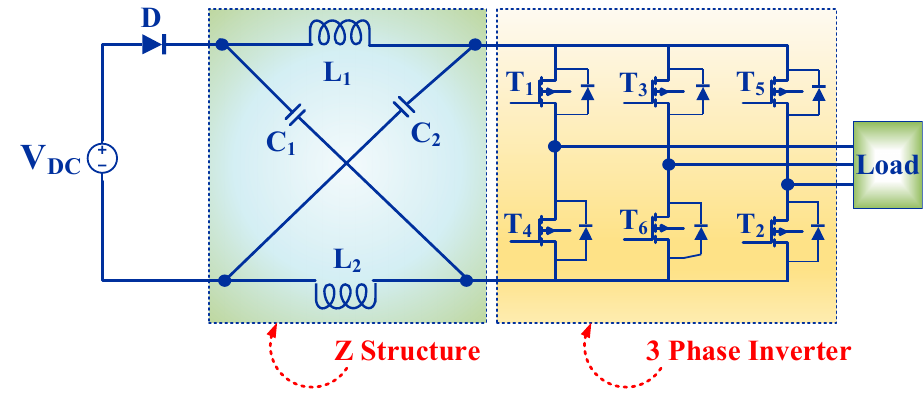
Figure 11. Circuit diagram of ZSI.